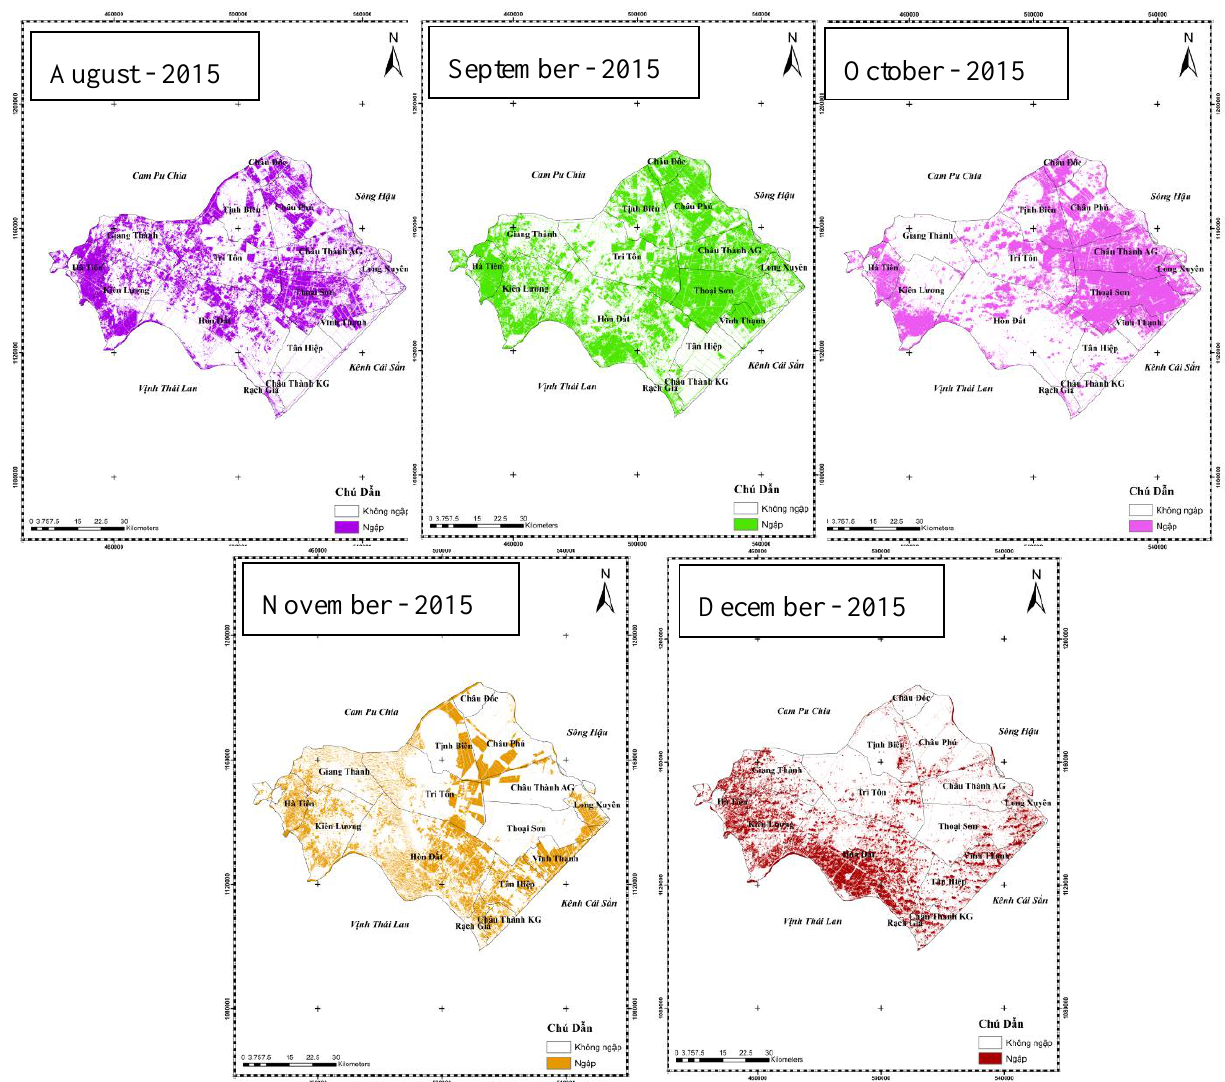
Figure 2: Flood maps distribution from August to December, 2015 in